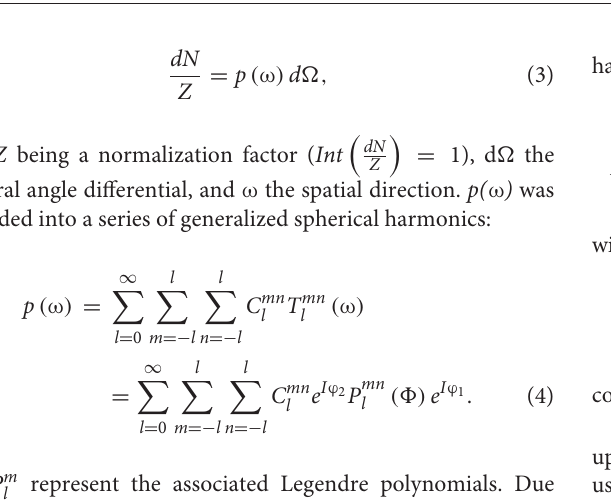
FIGURE 3 | Three steps toward pliODF generation. (A) First, a FOM is divided into regular domains or super-voxels. The exemplarily enlarged super-voxel contains 40 × 40 × 1 native voxels representing three predominant fiber orientations, which show a relative frequency of occurrence of ∼ ¼ (blue color), ∼ ¼ (magenta color) and ∼ ½ (cyan color), respectively. The color sphere defines the relation between orientation and color-coding. (B) Second, a normalized directional histogram with a discretized binning on a unit sphere is created for each super-voxel. The relative fraction of fiber orientations assigned to a particular bin is reflected by the length of the colored solid angle originating from the middle of the sphere. The symmetry of the histogram with respect to point reflection across the center of the sphere is evident. Here, the total number of bins distributed over the sphere was set to 164 and the three predominant input fiber orientations are still preserved. (C) Third, a spherical harmonics expansion is used to approximate each directional histogram. Depending on the selected depth of expansion (e.g., to the 4th or the 6th band), orientation distribution features might become occluded by